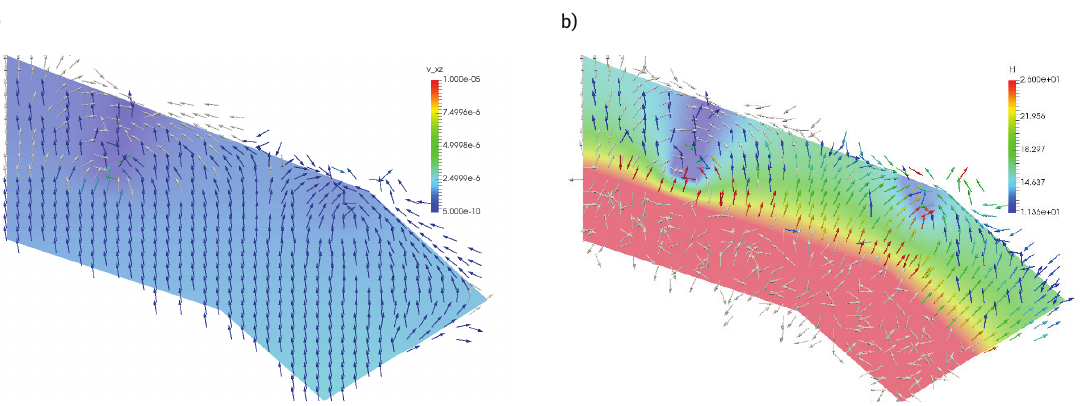
Fig. 11 Model geometry (10x exaggeration): 1. clay, 2. gravel, 3. gravel columns in clay, 4. drain, 5. Diaphragm wall.